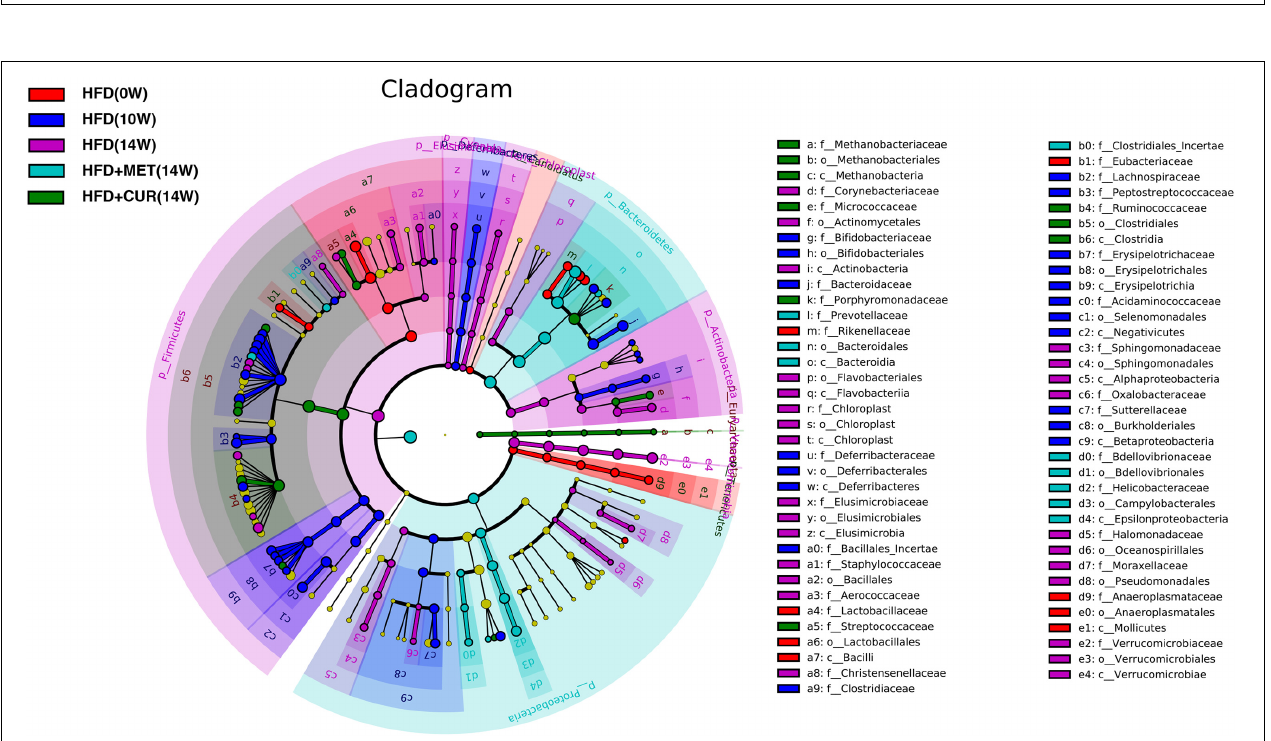
FIGURE 11 | Key bacterial alterations in response to the HFD, CUR, and MET treatments. Cladogram generated by the LEfSe analysis shows enriched taxa in feces from the HFD (0W, red), HFD (10W, blue), HFD (14W, purple), HFD + CUR (14W) (green), and HFD + MET (14W) (cyan) groups.